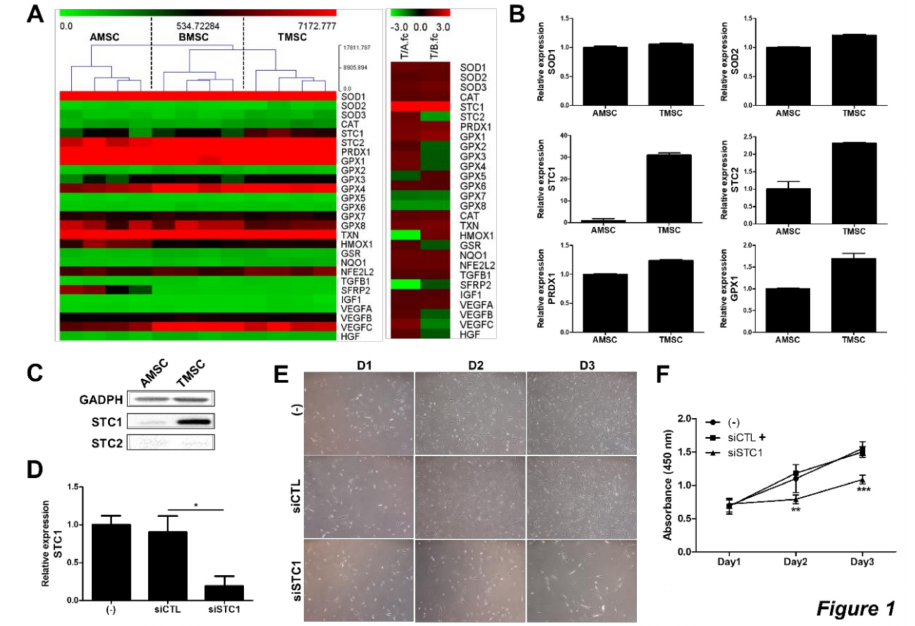
Figure 1. Functional expression of STC1 in TMSCs). Gene expression profiles for ROS-regulating factors were analyzed in TMSCs compared to BMSCs and AMSCs. T / A fc and T / B fc in right panel indicate fold change of TMSC / AMSC and that of TMSC / BMSC, respectively ( A ). mRNA expressions of pivotal factors for ROS regulation in TMSCs were determined by qPCR compared with those in AMSCs ( B ). STC1 and 2 expressions in protein level were detected by immunoblotting ( C ). siRNA for STC1 was transfected in TMSCs and cell viability was measured by MTT assay ( D ). Photographs of cells were taken at day 1, 2 and 3 after seeding of untreated TMSCs and siCTL- or siSTC1-treated TMSCs ( E ). Cell viability of siSTC1-treated TMSCs was determined by MTT assay compared to untreated or siCTL-treated TMSCs ( F ). Results are three technical replicates of TMSC from one donor. Representative results from two di ff erent TMSCs with similar tendency were presented. * P < 0.05, ** P < 0.01, *** P < 0.001. Results are shown as mean ±